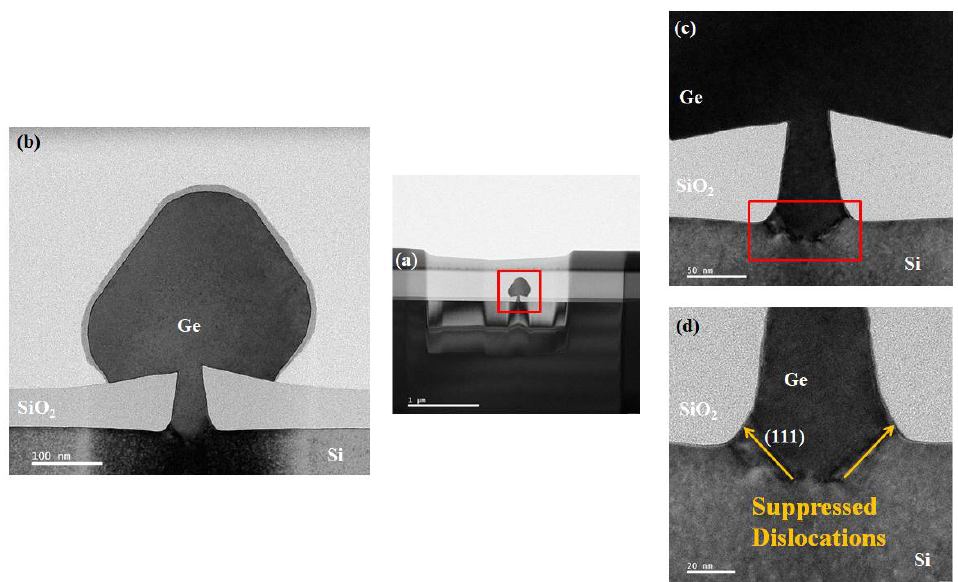
Figure 9. ( a , b ) Cross-sectional TEM image in the bright field of the selectively grown Ge-fin structure; ( c ) from the bottom of ( b ): interface between selectively grown Ge layers at the sides and bottom of silicon oxide mask; ( d ) magnified image of ( c ): clear illustration of the dislocation being suppressed by silicon oxide.